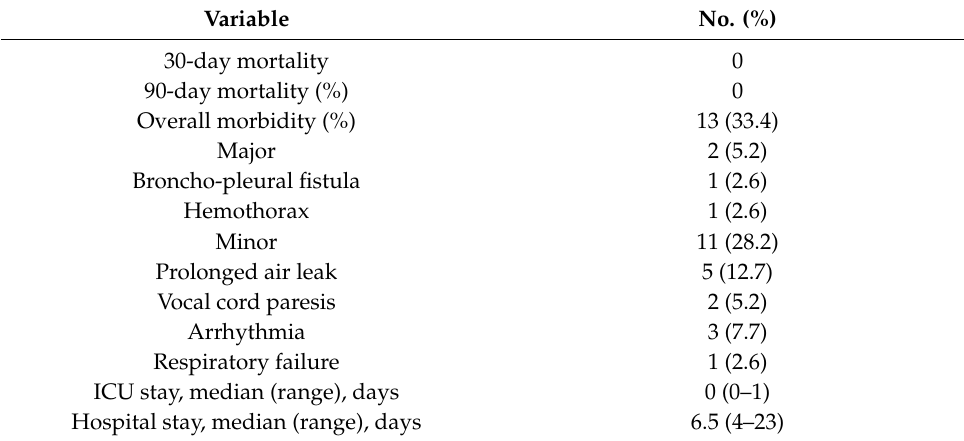
Table 3. Postoperative results of the resected patients ( n = 39).